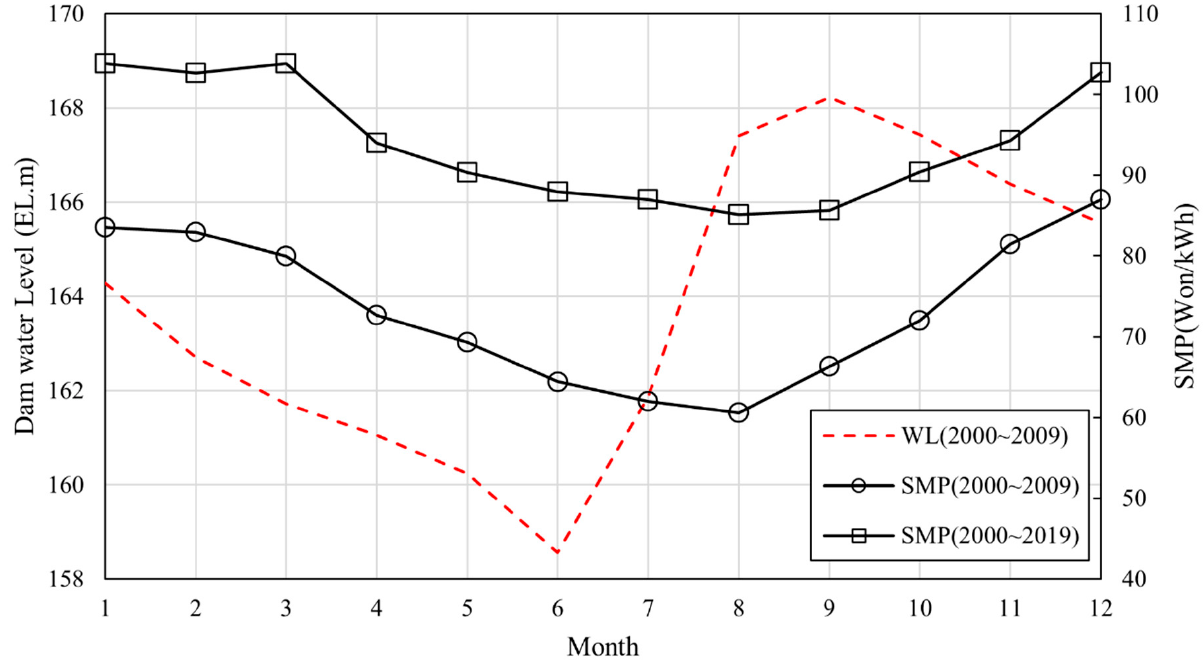
Figure 5. Comparison of monthly SMP price and water level at reservoir (2000~2019).